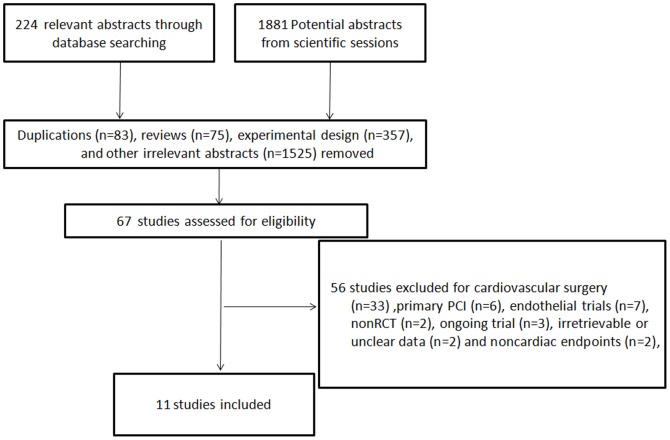
Searching process for the eligible studies.RCT, randomized controlled trial.